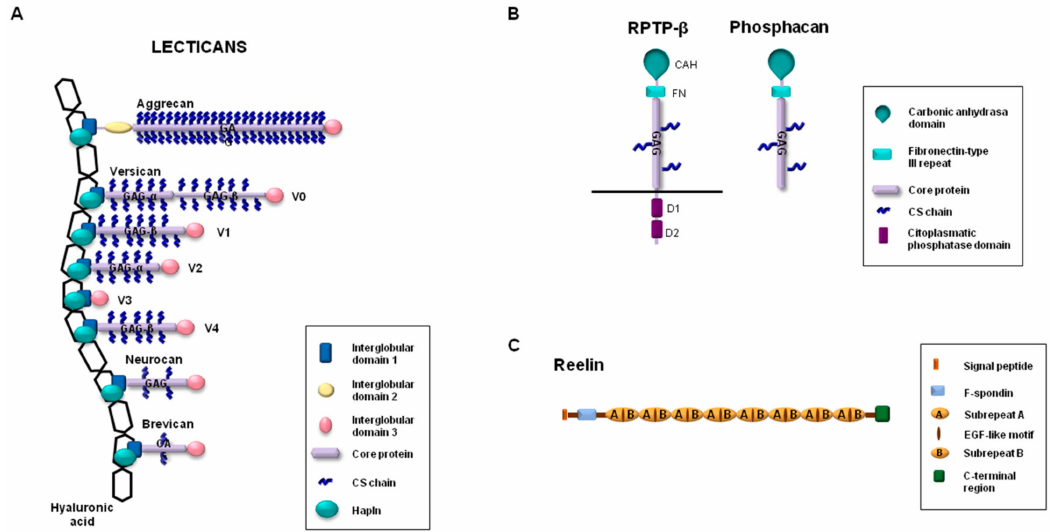
Figure 1. Schematic representation of ( A ) lecticans, ( B ) RPTP- β (receptor-type protein tyrosine phosphatase- β ), phosphacan, and ( C )